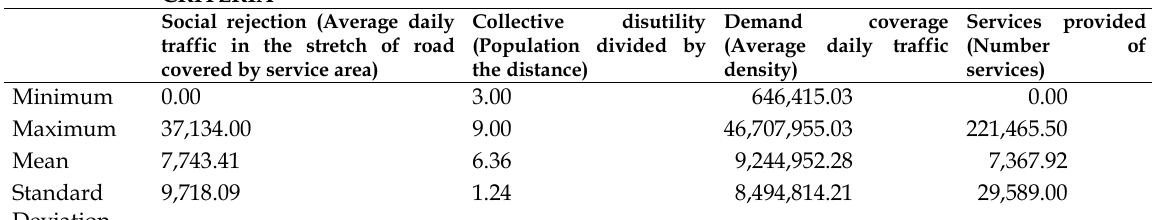
Table 2. Descriptive statistics of the